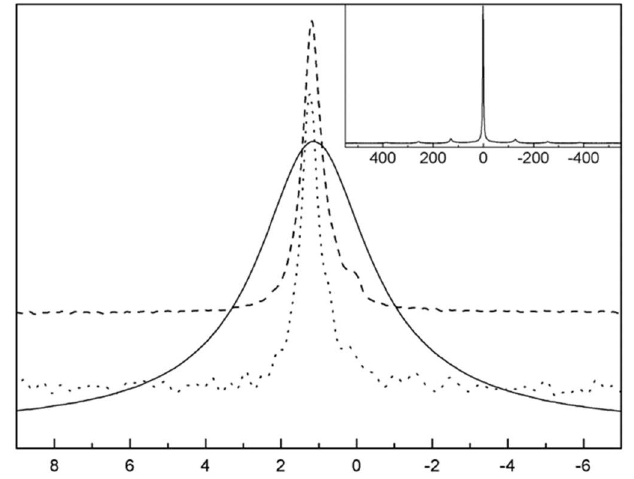
Figure 16. 7 Li (solid) and 6 Li (dotted) MAS spectra of t-LLZO prepared using natural abundance Li 2 CO 3 . The same 6 Li spectra (dashed) is also presented when prepared with enriched 6 Li [58] .